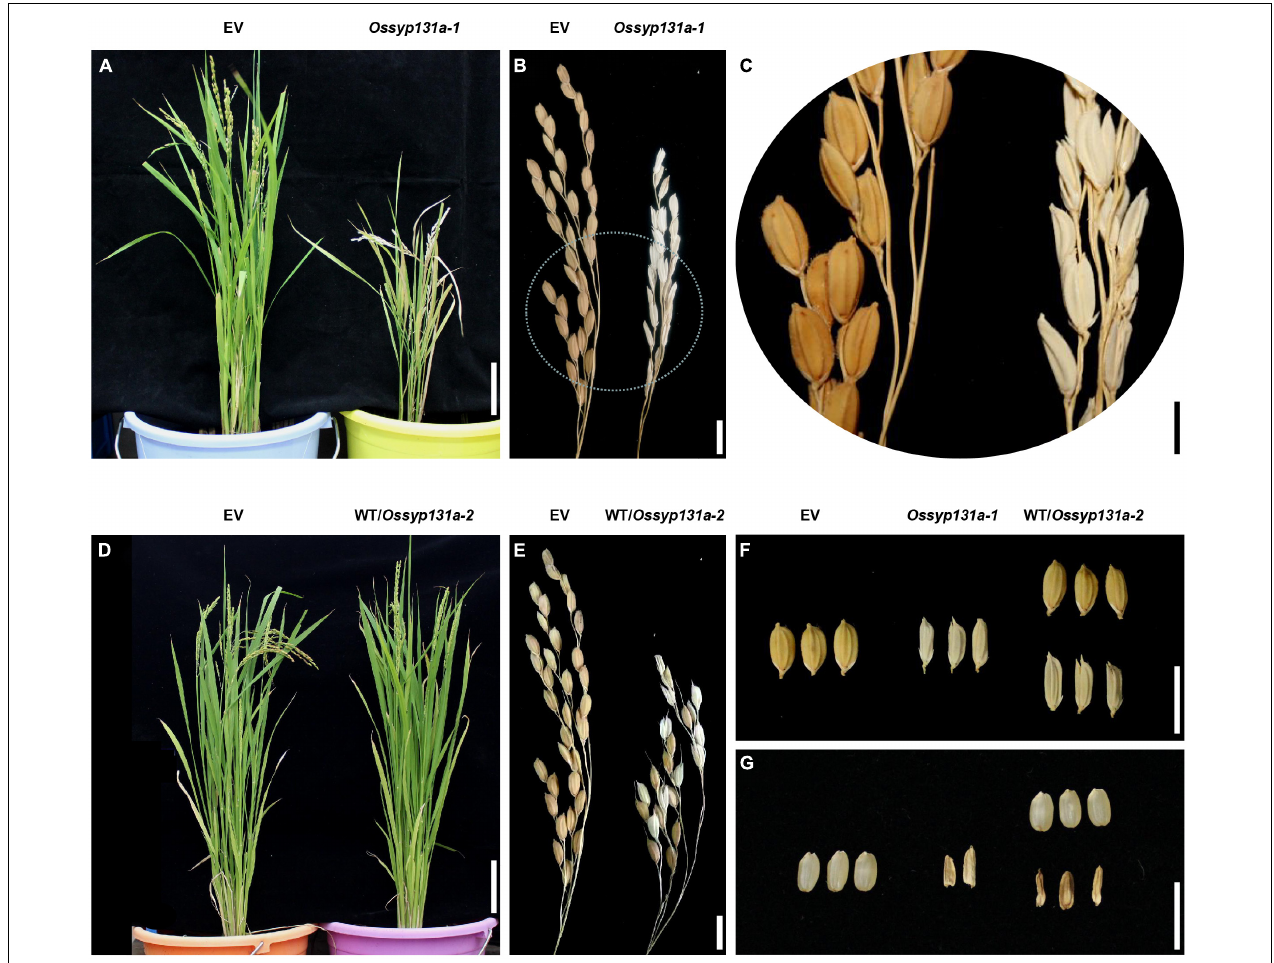
FIGURE 3 | The Ossyp131a T 0 mutants showed defects in growth and seed fertility (A–C) . The growth phenotype (A) and mature panicles (B) of a control T 0 rice plant (with an empty vector, EV) and a Ossyp131a-1 T 0 homozygous mutant; (C) An amplified circle region in (B) ; (D,E) , The growth phenotype (D) and mature panicles (E) of a control T 0 rice plant (EV) and a Ossyp131a-2 T 0 heterozygous mutant; (F–G) The rice grain morphology of control T 0 rice plant (EV), the Ossyp131a-1 T 0 homozygous mutant and the Ossyp131a-2 T 0 heterozygous mutant, either with husks (F) or without husks (G) . Scale bars = 10 cm (A,D) , 1 cm (B,E–G) or 0.5 cm (C)